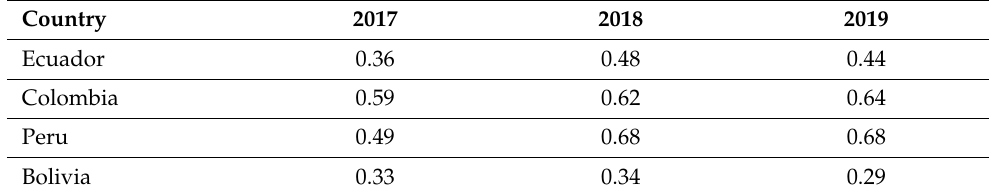
Table 14. The total scores in the country context dimension in the Andean Community members.